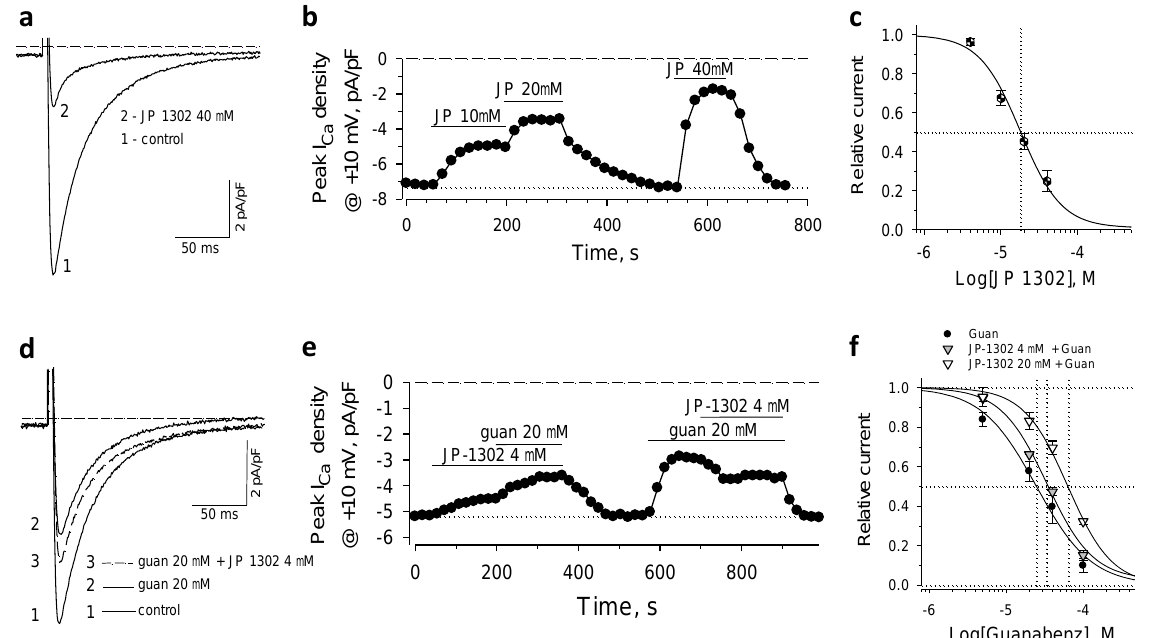
Figure 4. The effect of JP 1302, a specific antagonist of the α 2C isoform, on the guanabenz-induced suppression of I CaL . ( a , b ) Representative I CaL recordings and time-course of peak I CaL density values measured in the presence of JP 1302 alone. ( c ) dose-response relationship of JP 1302-induced suppression of I CaL (the Hill’s plot parameters in the text). ( d , e ) Representative I CaL recordings and time-course of peak I CaL density values obtained at low concentration of JP 1302 that reversed guanabenz-induced suppression of I CaL . ( f ) JP 1302 induced rightward shifts of dose-dependent inhibition of I CaL by guanabenz (the Hill’s plot parameters in the text). The relationships in the presence of JP 1302 were constructed relative to the current values measured in the presence of the antagonist alone.